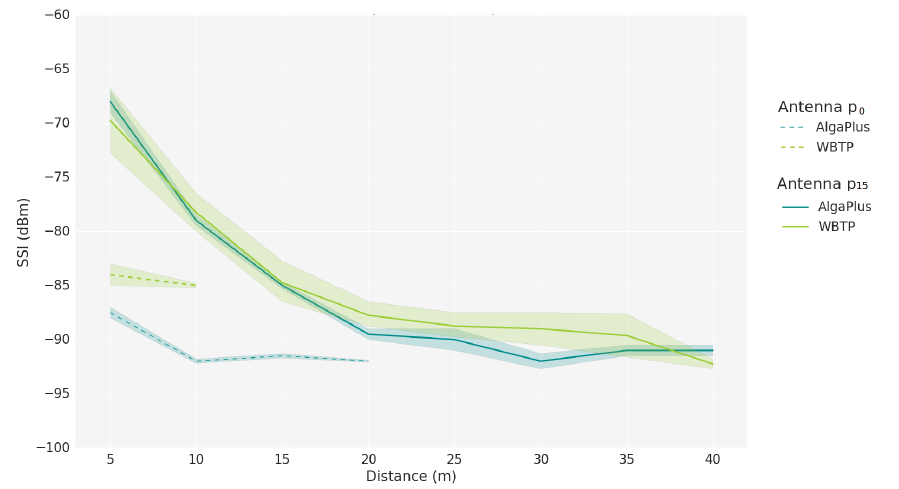
Figure 9. Signal Strength Indicator versus